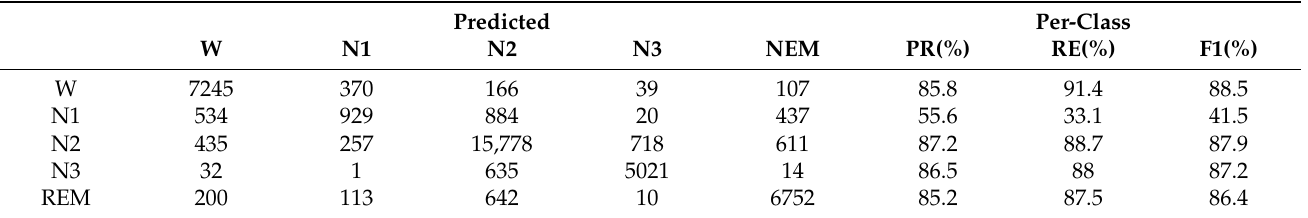
Table 3. Confusion matrix and per-class metrics of applying Siamese AEs to the baseline sleep staging model on the SleepEDF dataset, using 20-fold cross-validation.